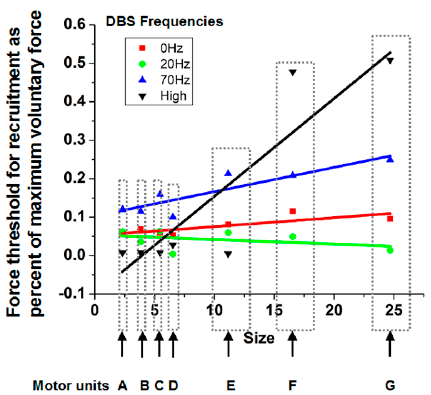
Figure 4. Relationship between percent of maximum force at which each of the seven motor units were recruited and the size of the motor units for different DBS conditions for a representative subject with Parkinson’s disease. The seven motor units (A–G) are ordered according to motor unit size: A is the smallest and G is the largest. Different symbols and colors represent the various DBS conditions. A flat or small slope indicates that the Henneman Size Principle did not hold under that DBS condition. An initially relatively flat slope for the untreated patient (0 Hz DBS) increases greatly with therapeutic (high) DBS, suggesting that motor unit recruitment has become normalized.